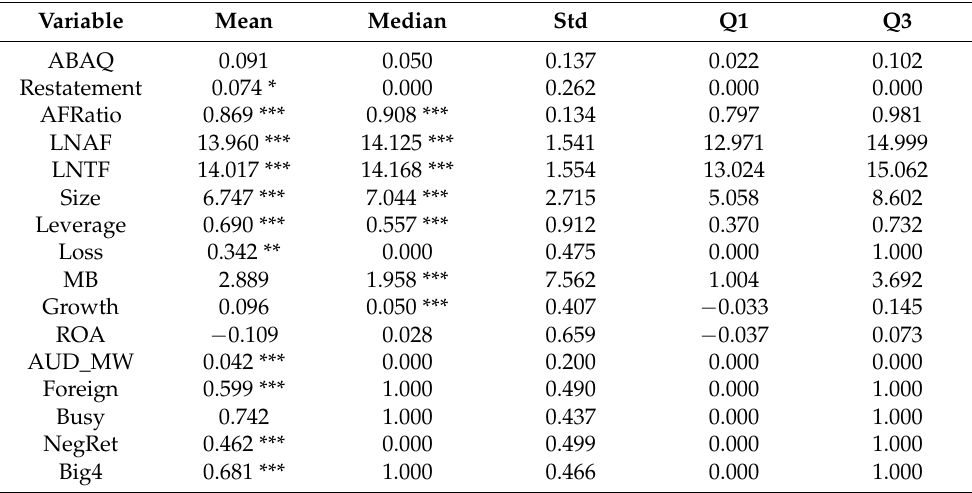
Panel F: Descriptive Statistics for the ABAQ, Restatement, and AF of U.S. sample firms in 3-year post-Rule 3211